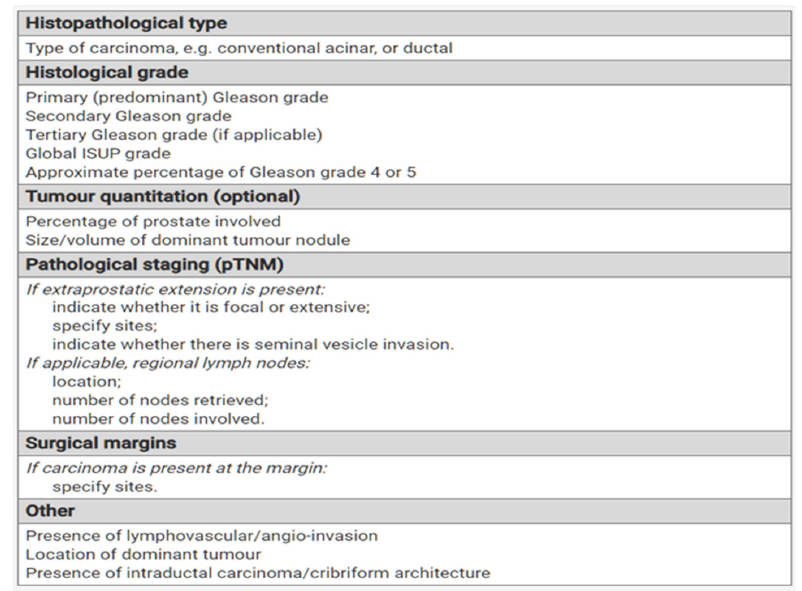
Figure 1. International Society of Urological Pathology (ISUP) 2014 grade (group) system.